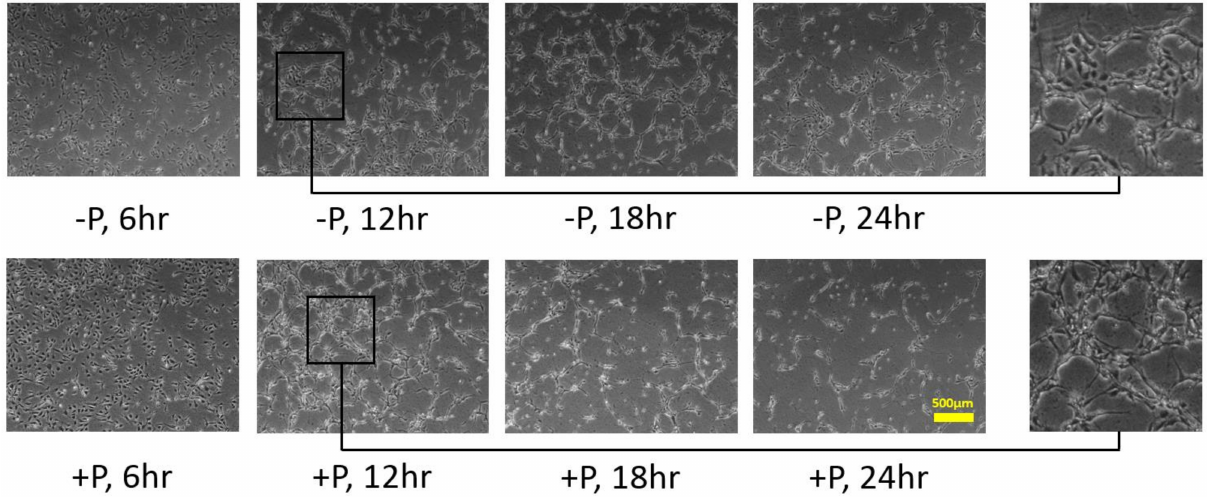
Figure 5. HUVECs distribution with and without VBP addition. In the -P case, which means without the VBP addition, HUVECs showed the change in morphology at 12 h with some cells remaining in the cobblestone shape and subsequently formed the capillary-like networks at 18 h. In the +P case, which means with the VBP addition, most HUVECs showed the morphological change at 12 h; however, the network could not form afterward.